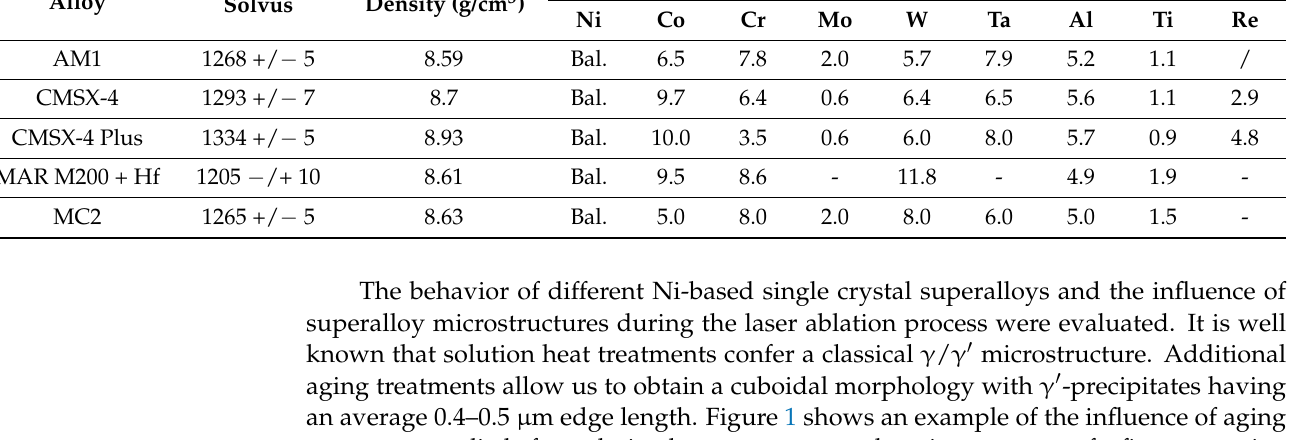
Table 1. Chemical compositions of the studied Ni-based single crystal superalloys. Alloy